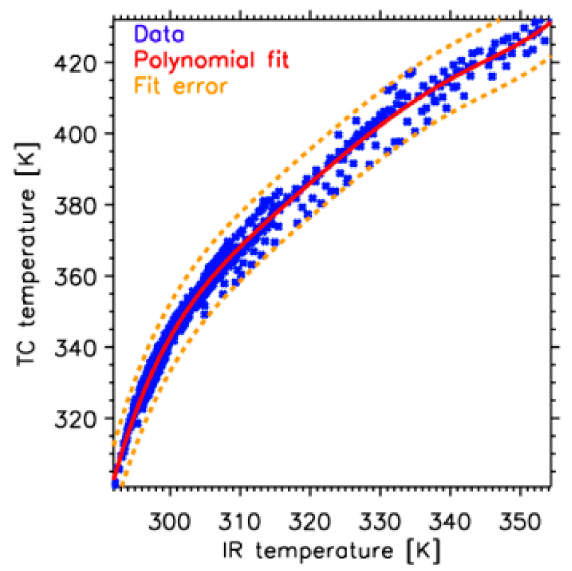
Figure 7. Infrared thermography calibration based on wall mounted thermocouples